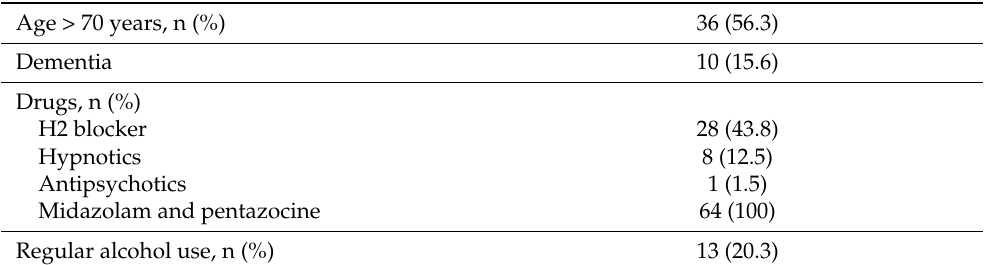
Table 2. Risk factors for